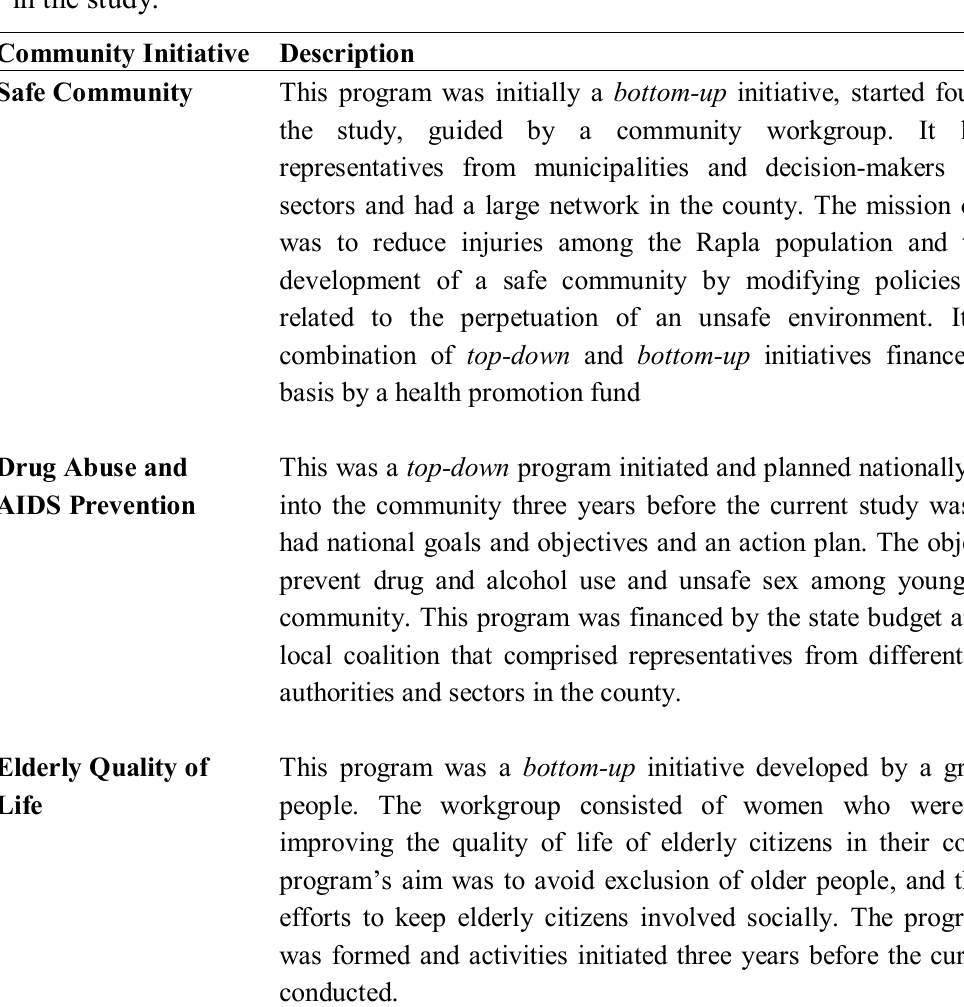
Table 1. Three community health promotion and disease prevention initiatives considered in the